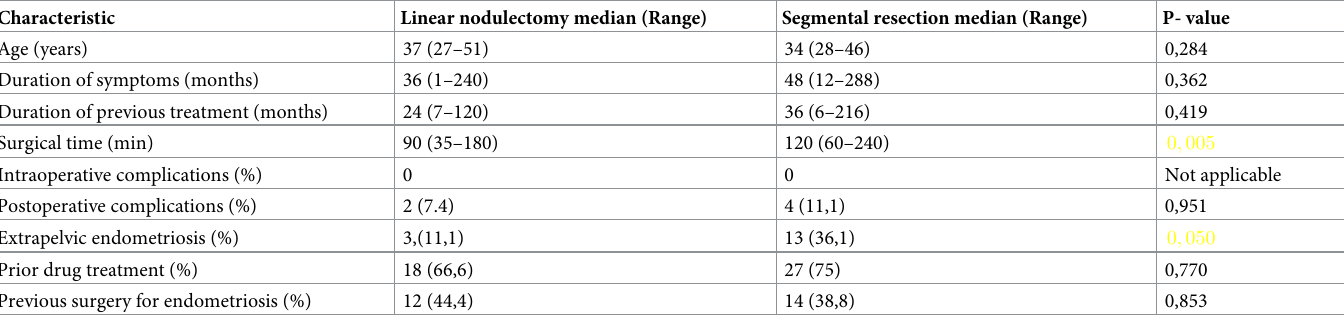
Table 1. Demographic and surgical data of 63 patients that underwent intestinal endometriosis resection by linear nodulectomy or segmental resection at Santa Casa de S ã o Paulo, 2010–2014. Characteristic Linear nodulectomy median (Range) Segmental resection median (Range) P-